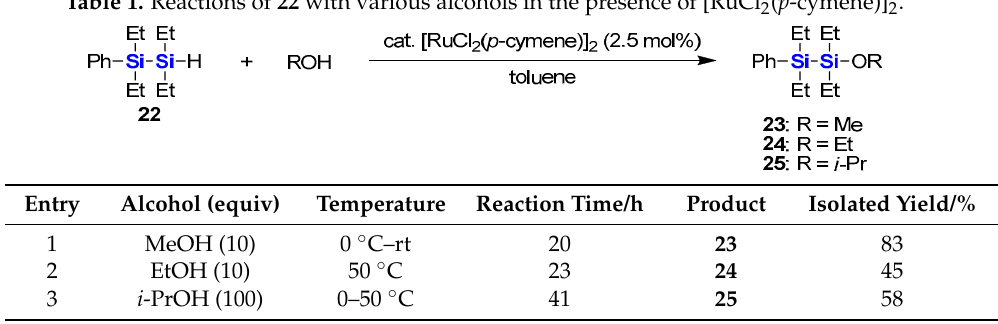
Table 1. Reactions of 22 with various alcohols in the presence of [RuCl 2 ( p -cymene)] 2 .